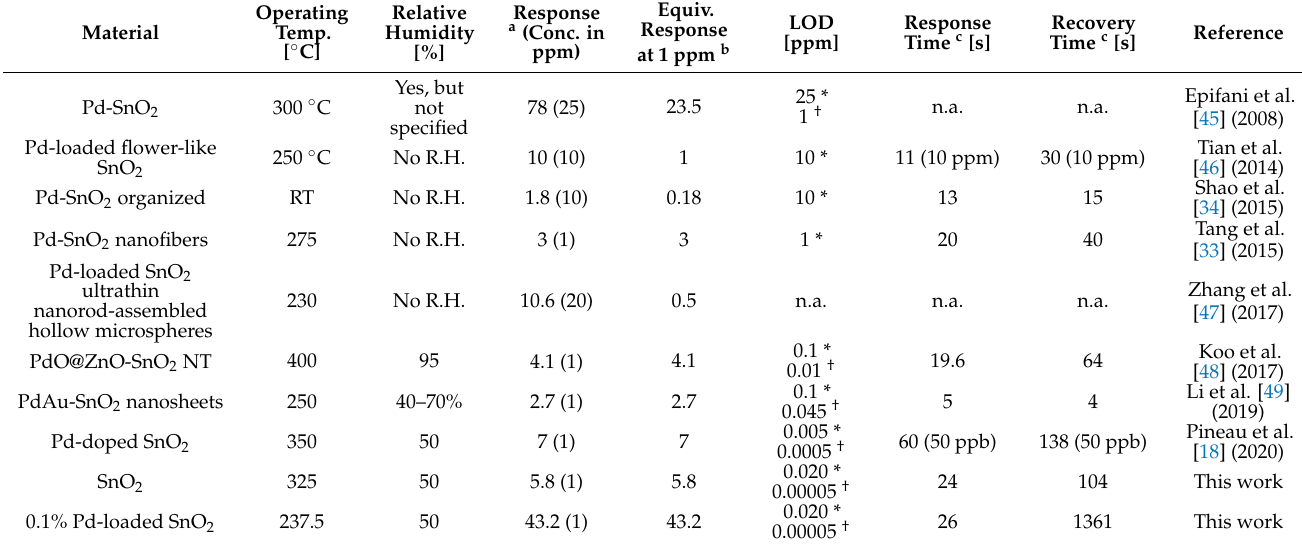
Table 2. Comparison of reported Pd-SnO 2 sensors for acetone detection with their key performance indicators.